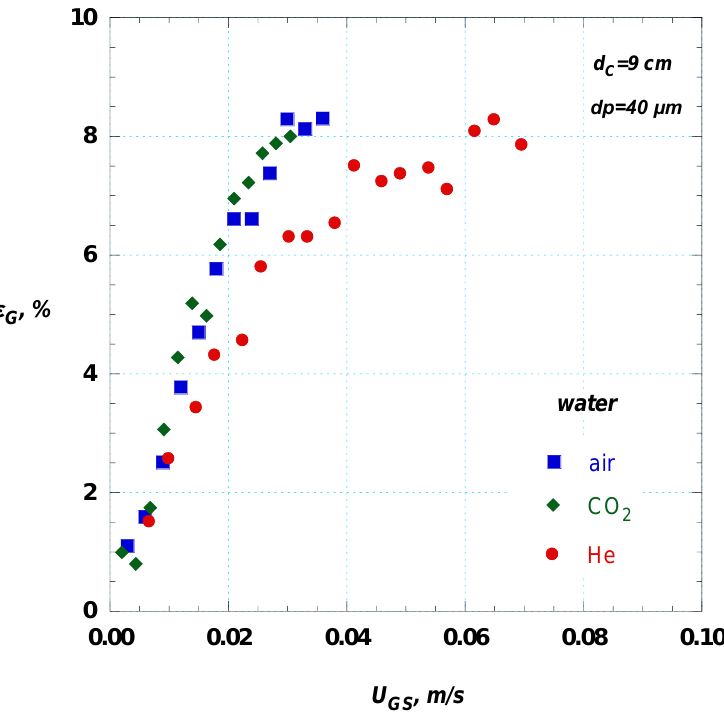
Figure 7. Effect of type of gas on gas holdup ( d p = 40 μm, d c = 9 cm).